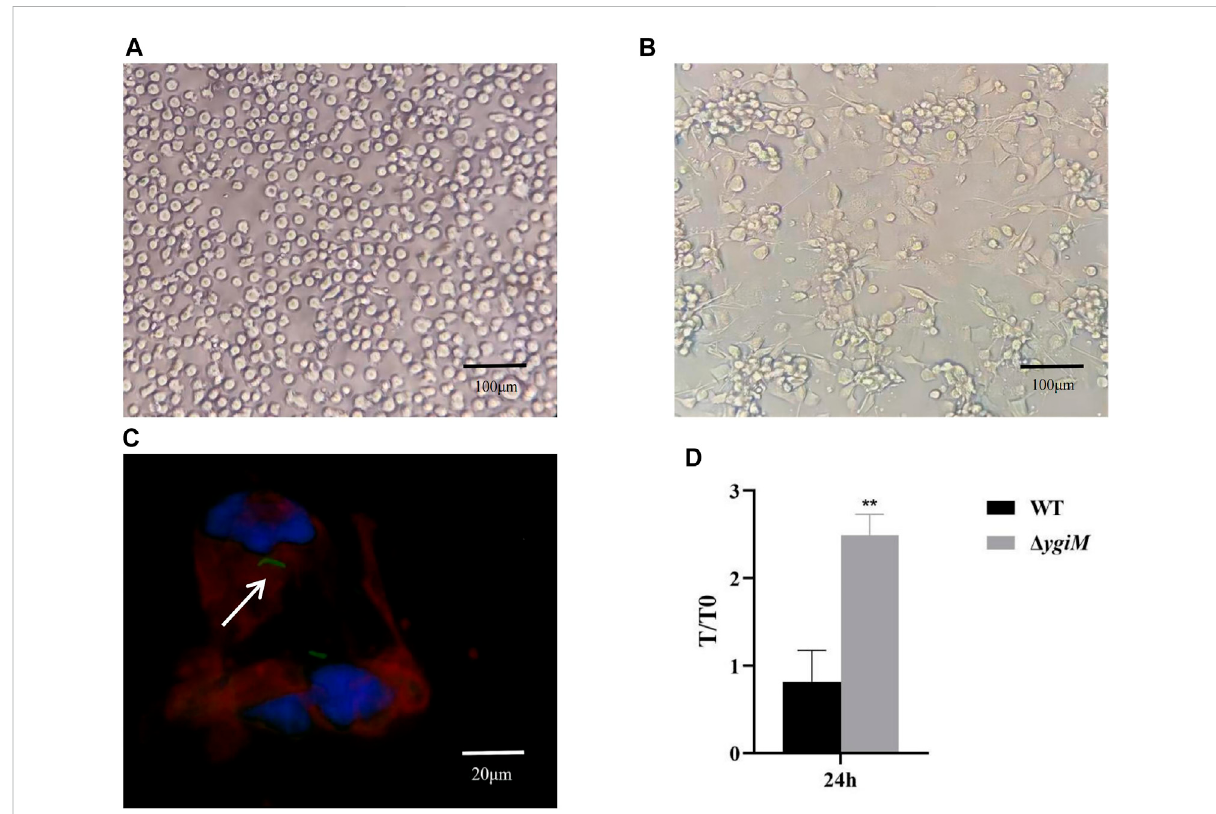
Determination of phagocytosis resistance of the wild type and the ygiM gene mutant strains. (A) THP-1 cells before induction (round, clear nuclei). (B) THP-1 cells are induced into macrophages by PMA (with pseudopodia, indistinct nuclei). (C) Fluorescence images of